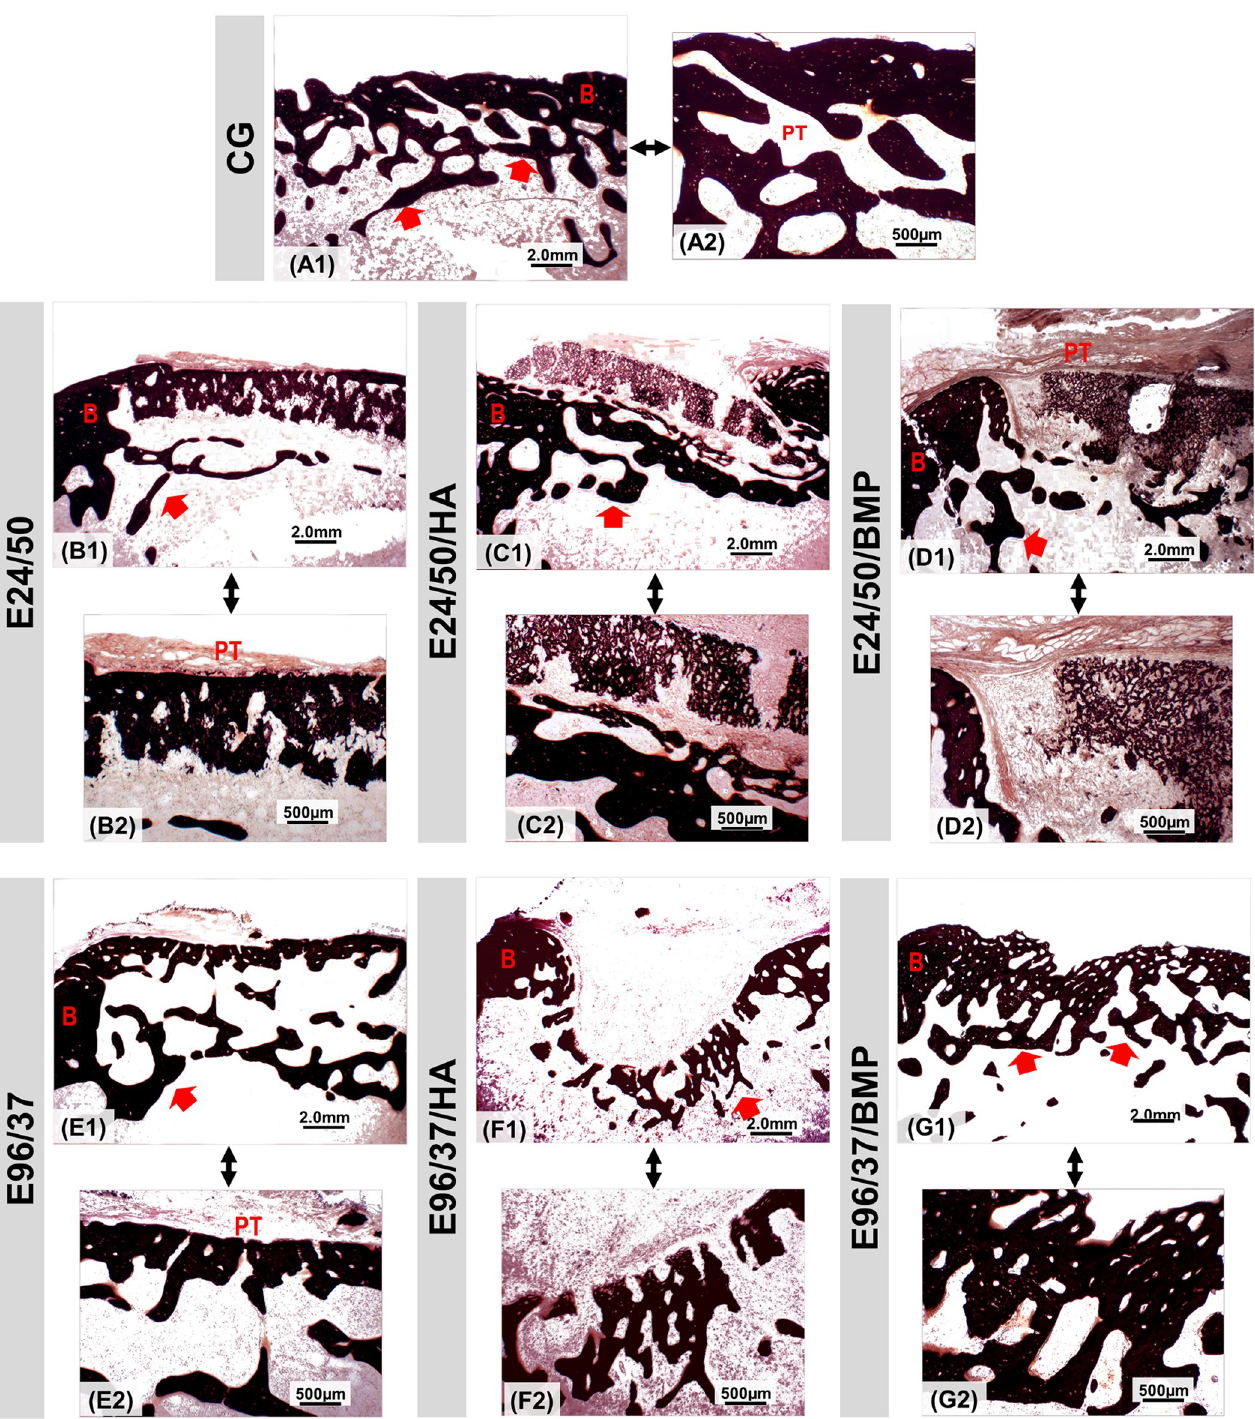
Fig 7. Von Kossa stained section at the metaphyseal region of the distal rat femur at 4x (A1-G1) and 10x (A2-G2) magnifications for groups: E24/50, E24/50/ HA, E24/50/BMP, E96/37, E96/37/HA e E96/37/BMP. Periosteal tissue (PT); trabecular plate (red arrow); surgical site border (B). Bar: 2.0 mm and 500 μ m.